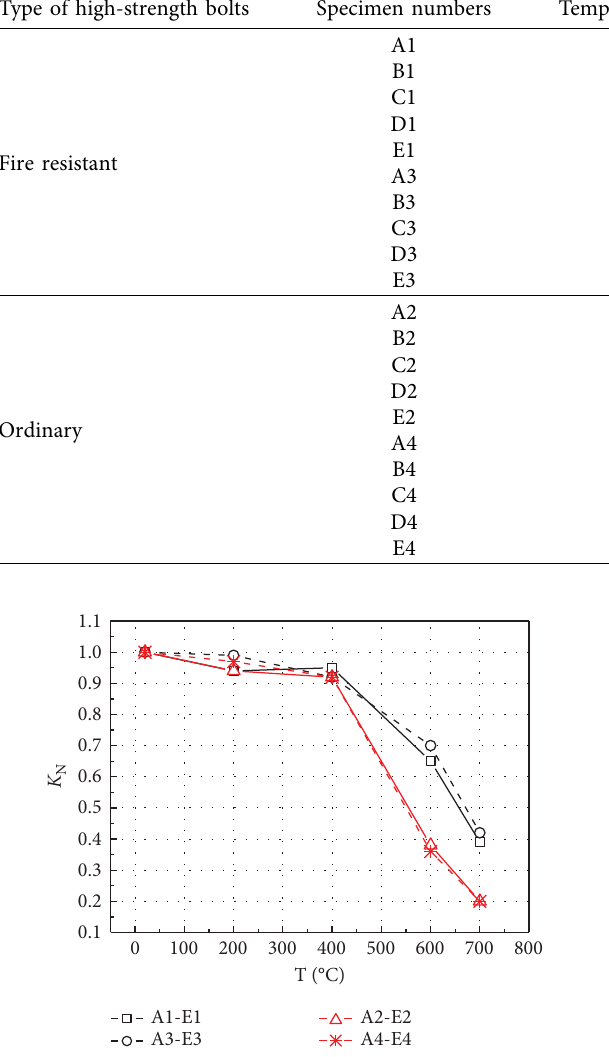
Figure 7: Te relationship between K